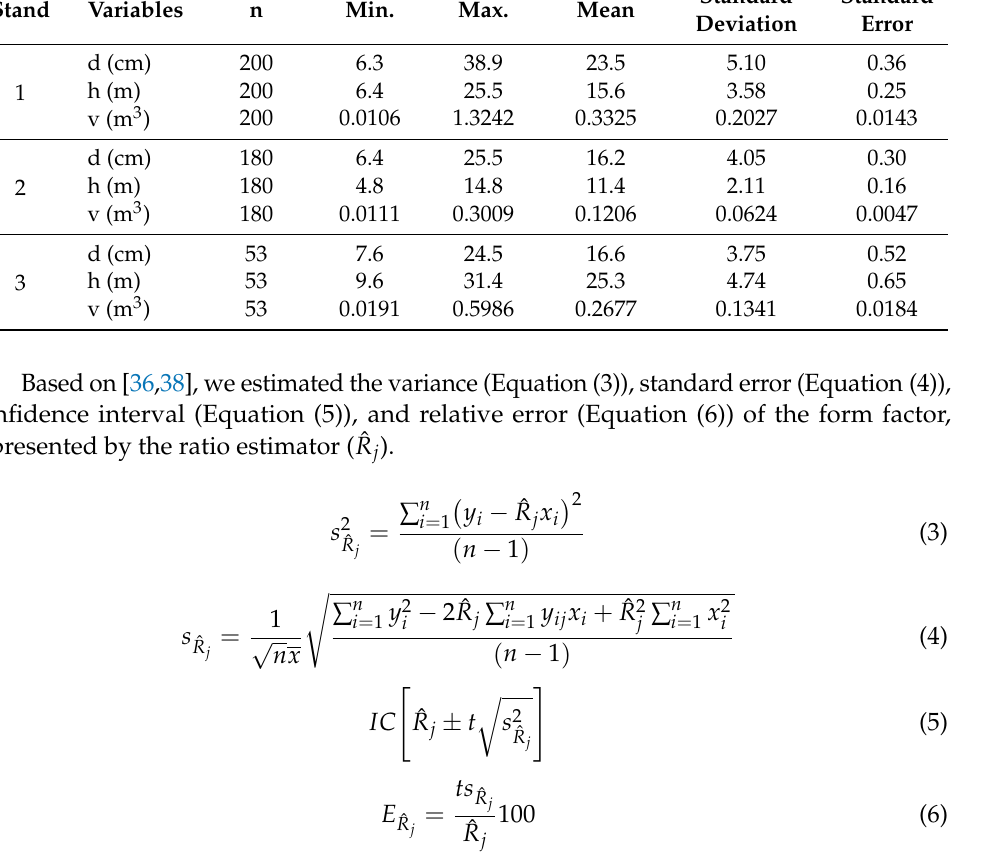
Table 1. Summary statistics of the stem volumes used to determine the ratio estimators. Stand Variables n